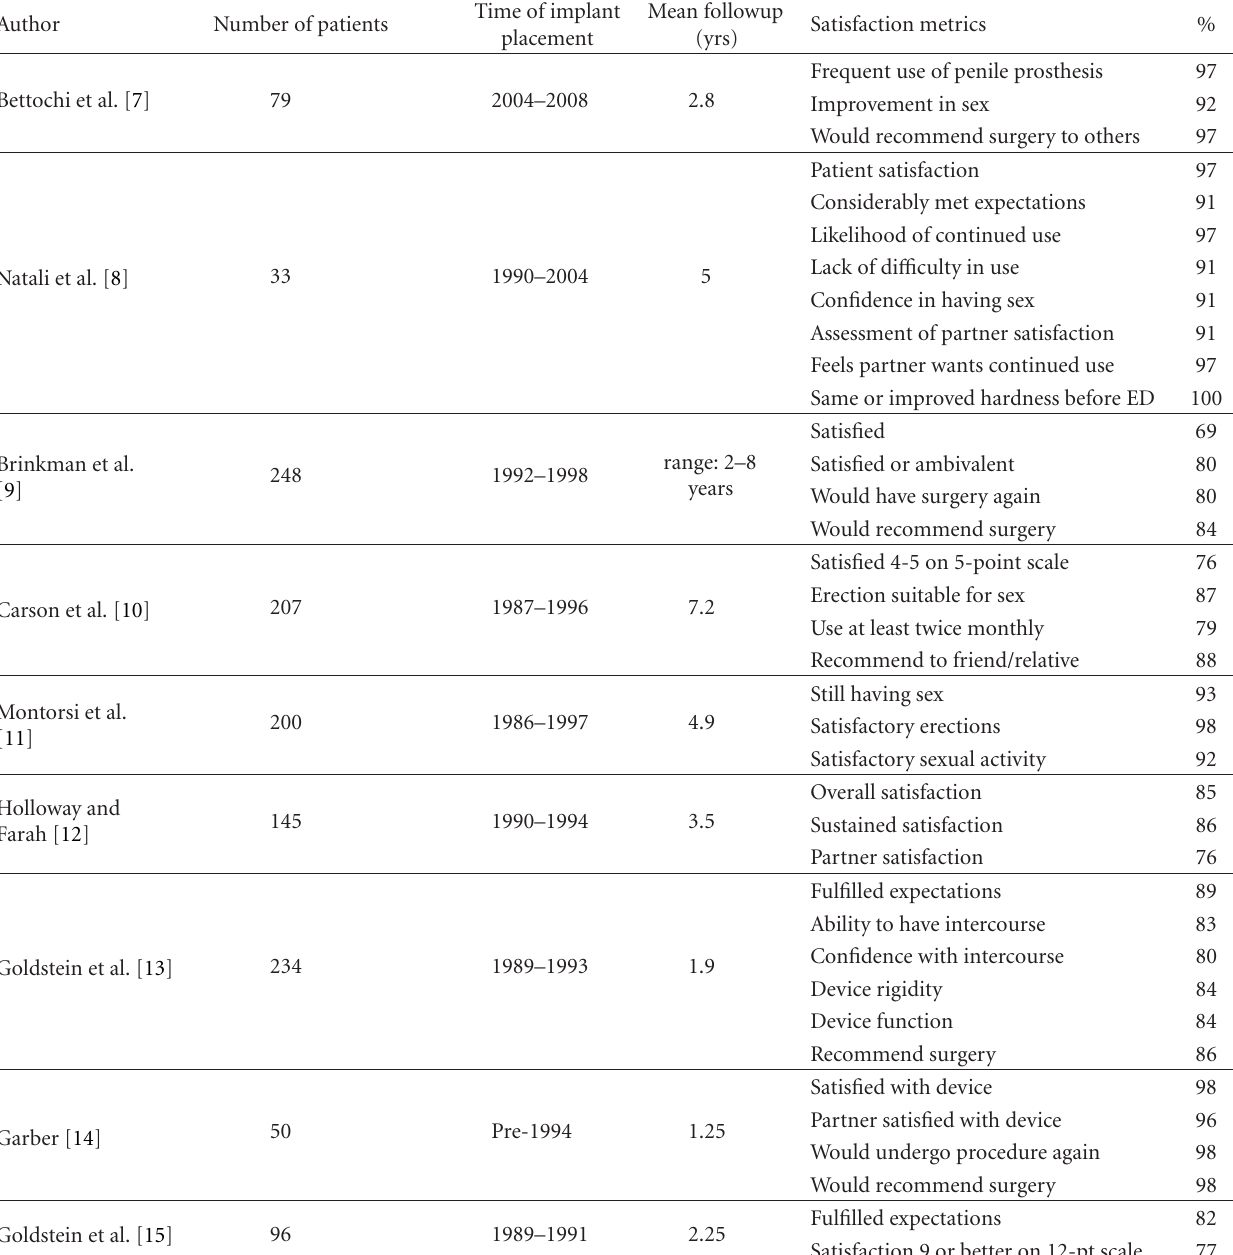
Table 1: Summary of